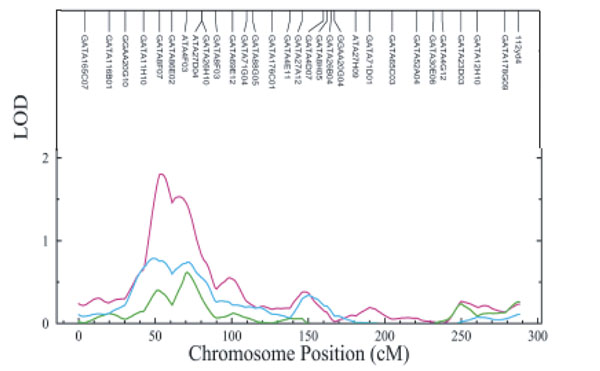
Multipoint LOD plot for TC-TG factor, TC, and TG on chromosome 2 Line colors: TC-TG factor (pink), TC (turquoise), and TG (green).